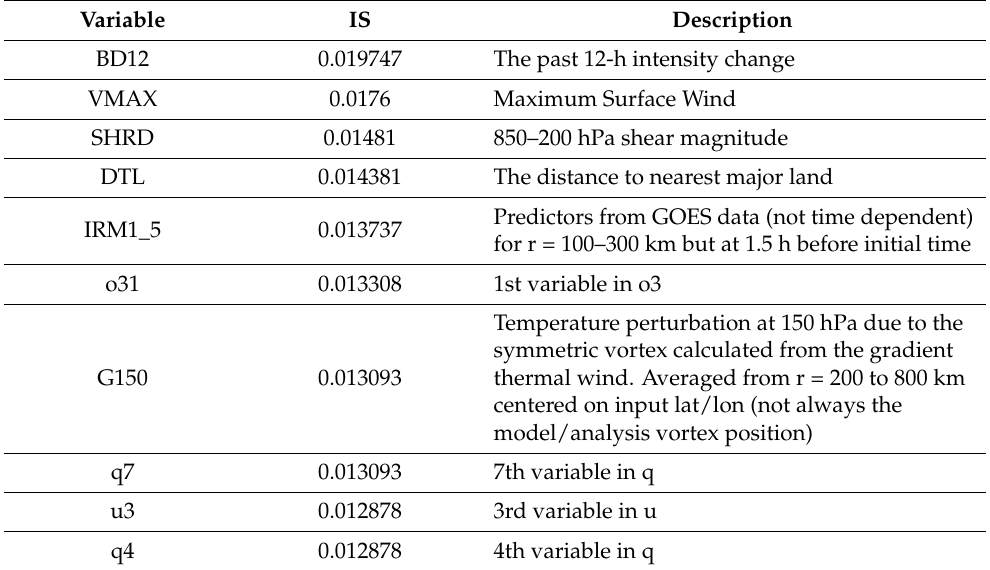
Table 6. The variables with top 10 importance scores (IS) in the TCNET model and their description.